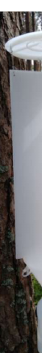
Figure 2. The unpainted, white cross-vane trap IBL-5, with dispensers located according to the instruction provided by the producing company SEDQ (Spain): the dispenser with bark beetle kairomones is located in the upper part of the trap, two dispensers with α-pinene in the middle, and the dispenser with the aggregation pheromone in the lower part of the trap. The studies were conducted in the Międzychód FD (N 52.6794, E 15.6944), in two 83- year-old pure Scots pine stands with moss vegetation cover. They were selected based on the availability of treetops left on the ground after thinning in the previous year, with signs of M. galloprovincialis infestation. Traps were set up in a randomized complete block design across 14 blocks (replicates) of quadratic (2 × 2) shape, with 6 or 4 blocks in each stand, and with each block containing one of each color variant. Traps within and between blocks were separated by approximately 100 m. Traps were set on 24 and 25 June and checked and emptied on 1 and 9 July. They were suspended on metal hooks from dead branches on trees, 4–6 m above the ground, using an adapted telescopic pole. Data from all trap inspections in the same experiment were not treated as replicates. Captured beetles ( M. galloprovincialis males and females separately, S. buprestoides and Thanasimus spp.) were counted in the laboratory, and up to 20 pine sawyer females in each trap were dissected, in order to check for the presence and to count developed eggs, which indicate female maturation. S. buprestoides and two Thanasimus species were counted only in the samples collected during the first trap inspection. The second experiment was conducted in 2020. Since no differences were found among the colors tested in 2019 (see Results), we decided to test the following six colors (Table 1): orange, blue, and green colors with lower reflectance values than those tested in 2019, a black color (commonly used in different countries [51,53]), and a pure white color, for comparison with white, unpainted coroplast. The materials and experimental design were similar to those used in 2019, so we describe below only those elements that were different. The vanes of the traps were painted twice with glossy acrylic spray paints (green from the ColorMatic series and other colors from the PrismaColor series produced by Schuller Eh‘klar, München, Germany) and then treated twice with the dry PTFE (MotipDupli Group B.V., Wolvega, The Netherlands). It is important to mention that, after spraying the vanes with the pure white paint, the final color looked rather yellowish. The experiment was conducted in the Międzychód FD (N 52.6684, E 15.8630) and Wronki FD (N 52.7608, E 16.2576), in 65–90-year-old pure Scots pine stands with mosses in a vegetation cover. Stands were selected using the same criteria as in the first experi- ment. Color treatments were tested in 10 blocks, and two block conformations were used, either 3 × 2 or 6 × 1, as dictated by the terrain relief. Traps were deployed on 29 and 30 June, and then checked and emptied on 15 and 29 July. Among the insects captured, we